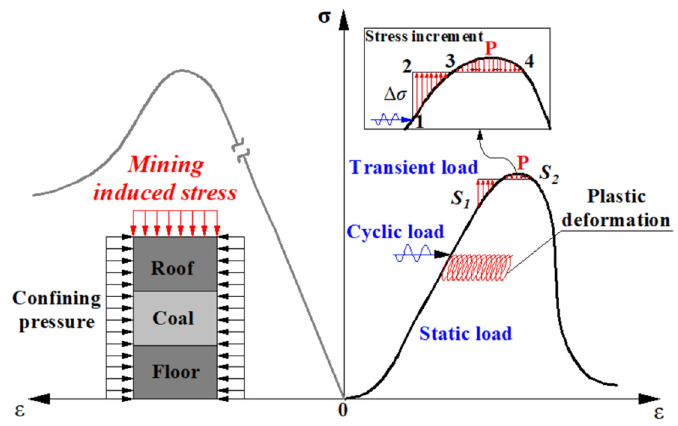
Figure 14. Triggering mechanism of coal burst under different disturbing mining-induced stress.